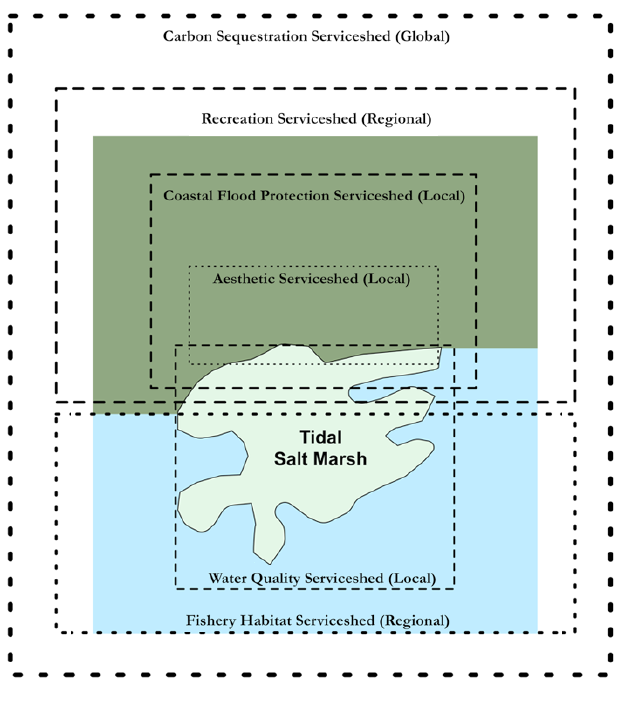
Fig. 1 . Multiple servicesheds for ecosystem services from a single tidal salt marsh property representing the multiple scales across which a conserved salt marsh property delivers